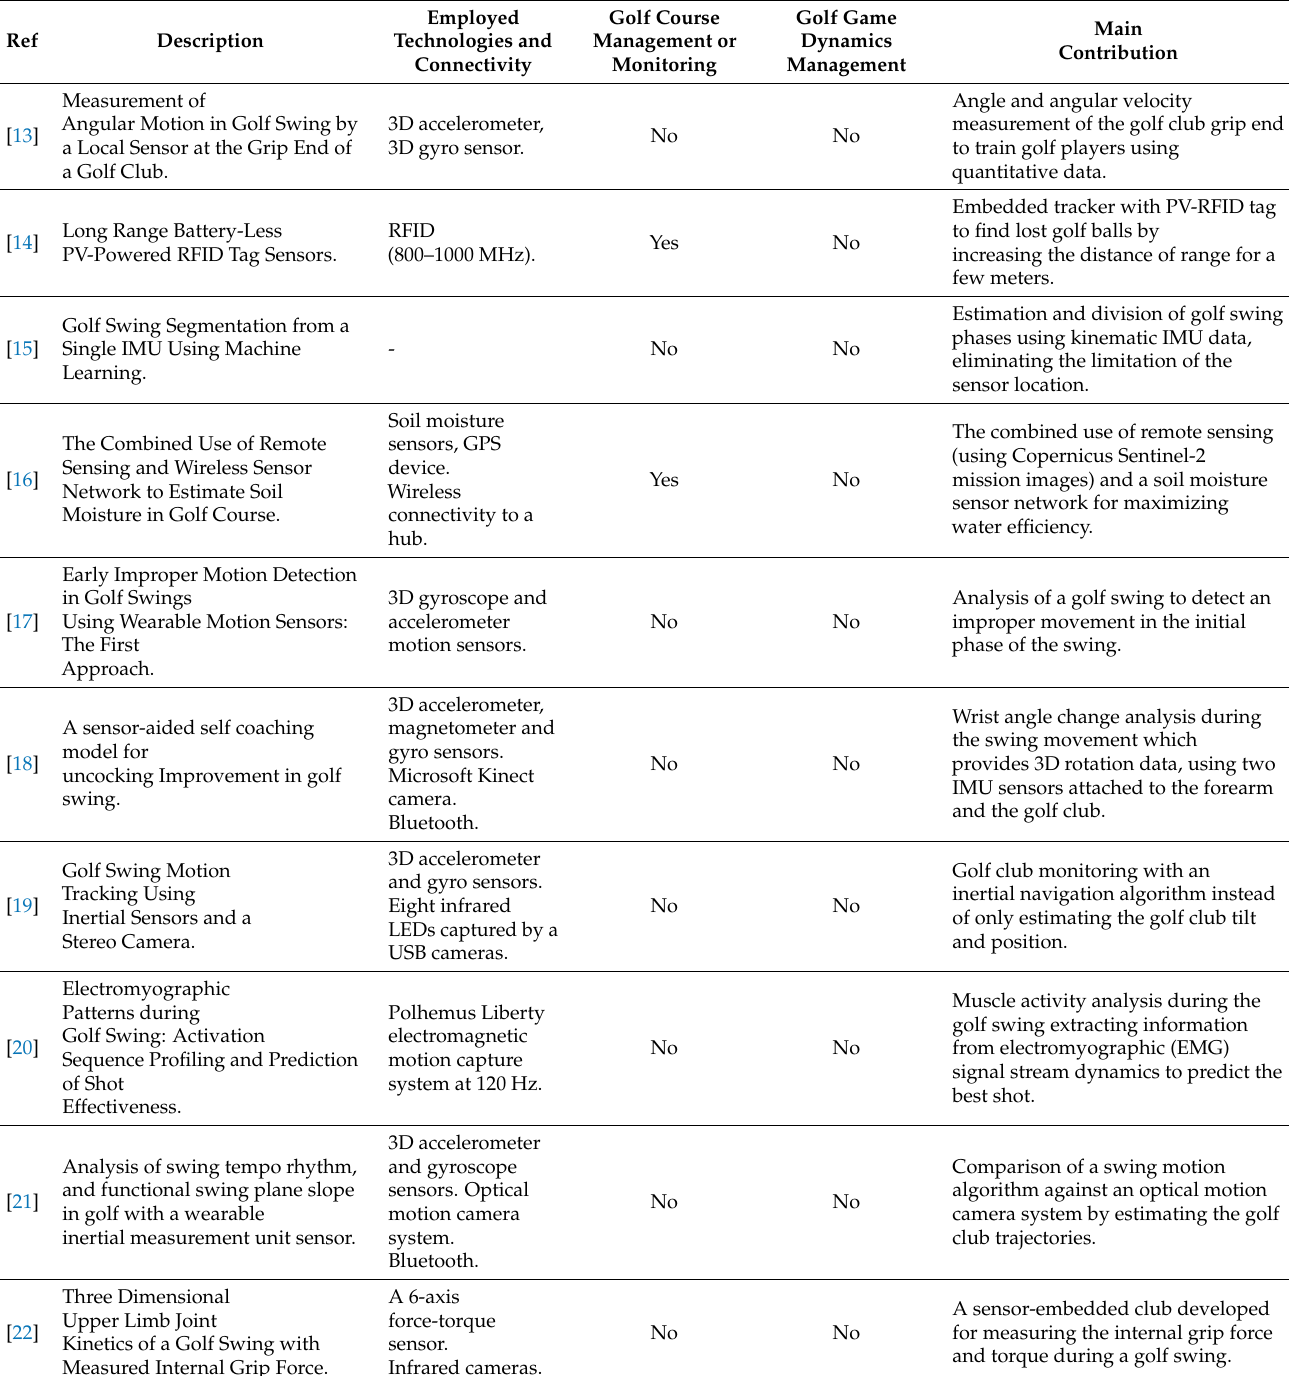
Table 1. Related work concerning golf